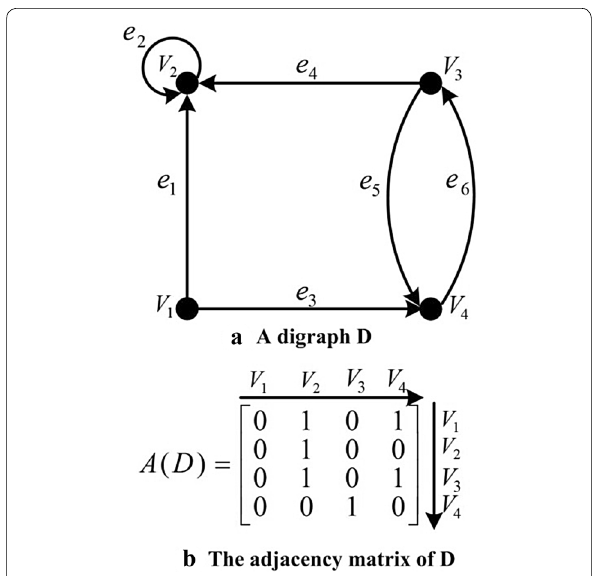
Figure 1 A digraph and its adjacency